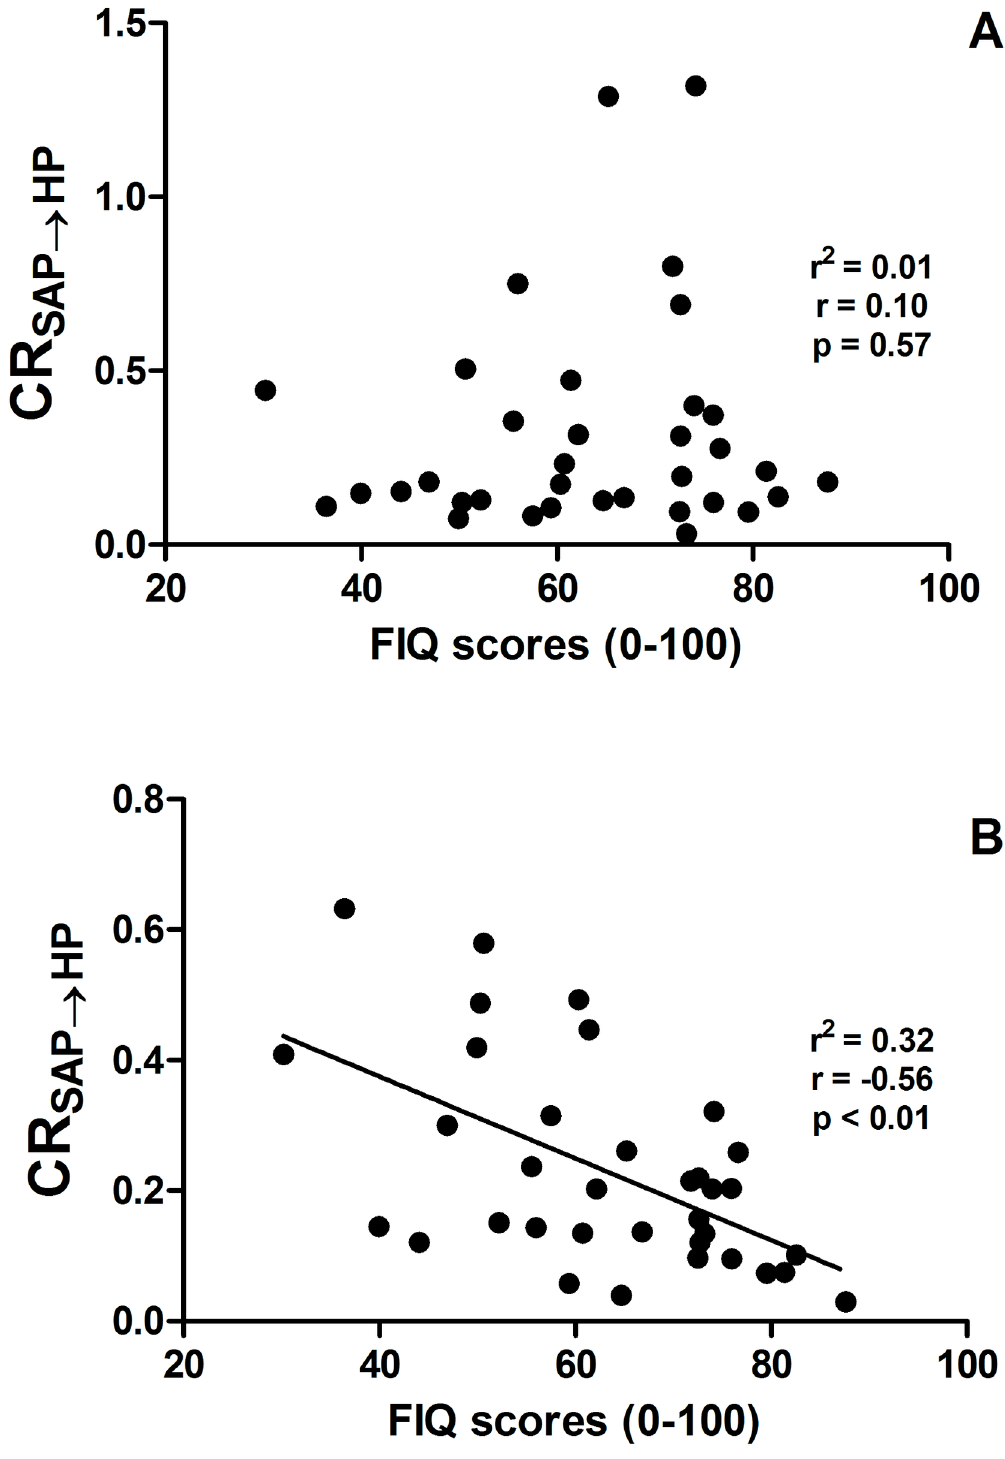
Fig 1. The scatterplots of CR SAP ! HP on FIQ score are shown at REST (a) and during STAND (b). Each solid circle is relevant to a pair (FIQ score, CR SAP ! HP ) computedover a single individual. The linear regressionis shown as well when a significant association betweenthe two variablesis found with p < 0.05.